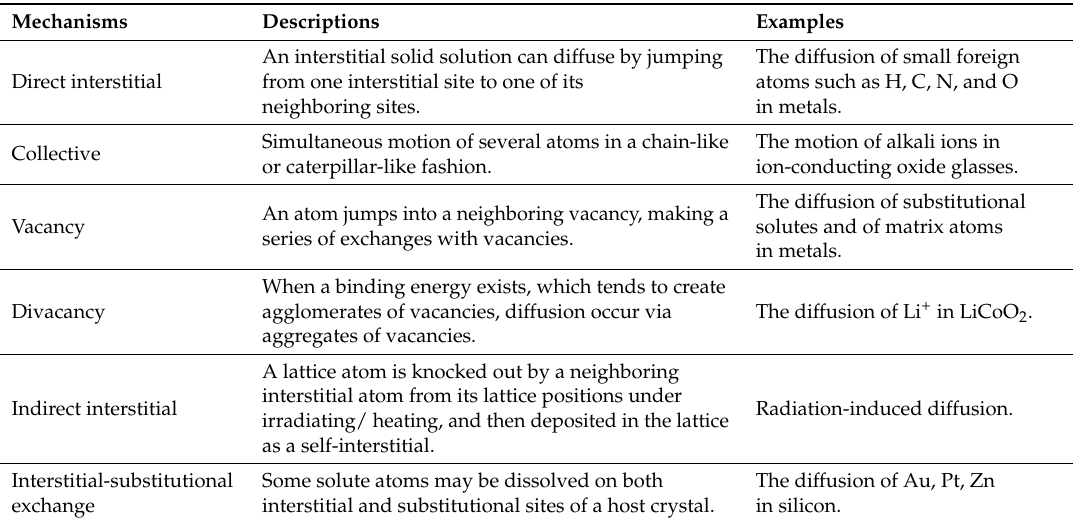
Table 5. Diffusion mechanisms in solids [97].